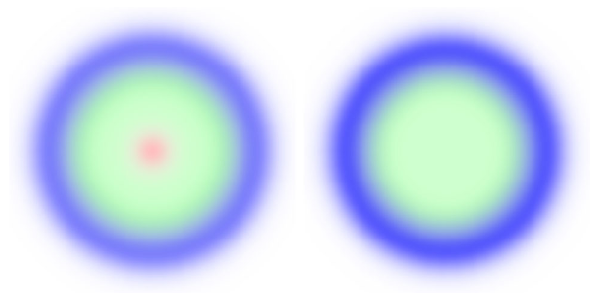
Fig. 3 Planar section depicting the contributions ρ 1 (red), ρ 2 (green) and ρ 3 (blue) to the total energy density for solutions of (18) with permeabilities (26). We depict the cases n 1 = 1, n 2 = n 3 = 10 (left) and n 1 = 0, n 2 = n 3 = 10 (right). The red vortex is absent from the picture on the right because ρ 1 =